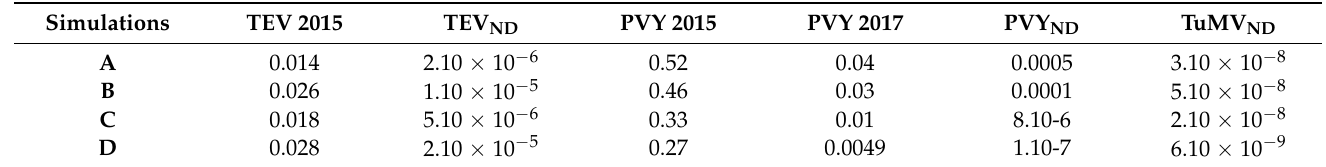
Table 2. p values of Xhi 2 test for percentage of NS mutations in IDRs between simulated and experimental data (TEV 2015, PVY 2015, PVY 2017) or natural diversity (TEV ND , PVY ND , TuMV ND ). There was no experimental datasets available for TuMV. Significance, p < 0.05.